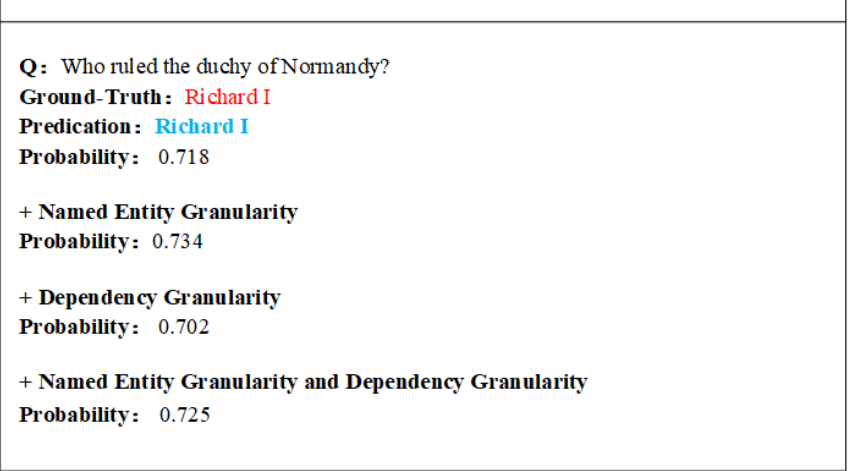
Figure 9. Effectiveness analysis. Example of the answer is the possibility of named